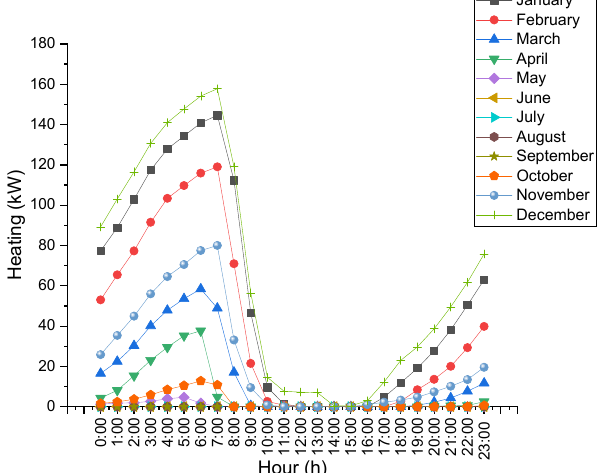
Figure 13. The thermal power of the GHP operated in heating mode for a year in Mexicali, Mexico.